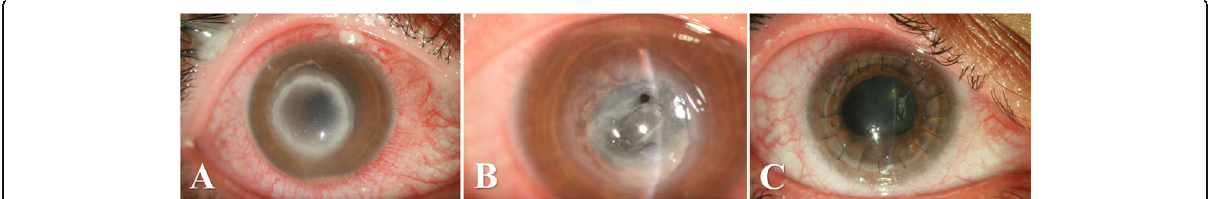
Fig. 1 Slit photographs of the right eye with post-SMILE keratitis. A , A dense paracentral ring infiltrates taking the shape of the small pocket created during SMILE procedure, on postoperative day 4. Corneal edema and epithelial defect are also seen. B , Severe extensive corneal thinning, and perforation. C , Tectonic penetrating keratoplasty (PKP) of the right eye